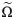
Decomposition of the variance in female life span across 96 mammalian species divided in three terciles of body mass (cf. Material and method section).(a) Effect sizes obtained by summing both positive and negative (co)variance terms. (b) Variance decomposition sensu stricto, allowing some parameters to offset the contribution of others via the covariance terms. All the observed contributions of mortality parameters to variation in life span were statistically different from the expectation under the null model described in the "Conformity test" section of the main text. A is the duration of the juvenile stage, aJ is the juvenile mortality hazard, a0 is the baseline prime-age adult mortality hazard, b is the rate of actuarial senescence, and Ω~ is the duration of the prime-age stage. The data for this figure are accessible online as S4 Data.